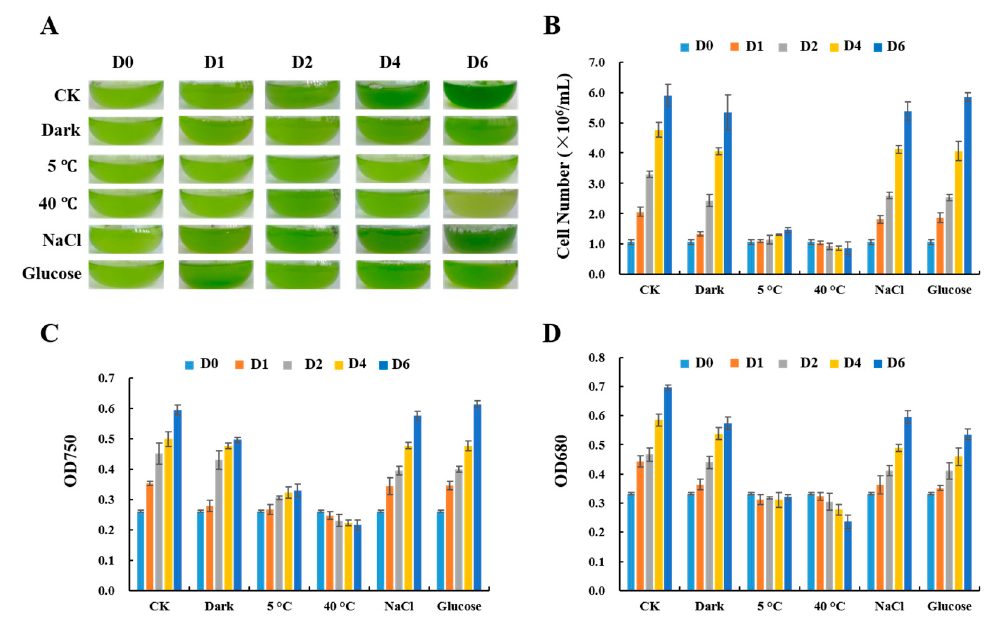
Figure 1. Culture appearance and cell density of Chlamydomonas reinhardtii grown under abiotic stresses. ( A ) Photos taken of C. reinhardtii at different time points during culture: control (CK), dark, cold (5 °C), heat (40 °C), NaCl (100 mM), and glucose (1% w / v ); ( B ) Cell number was determined using a hemocytometer under a microscope; ( C , D ) Optical density of the culture at 750 nm and 680 nm in various treatments. Data are the average values from three independent experiments.